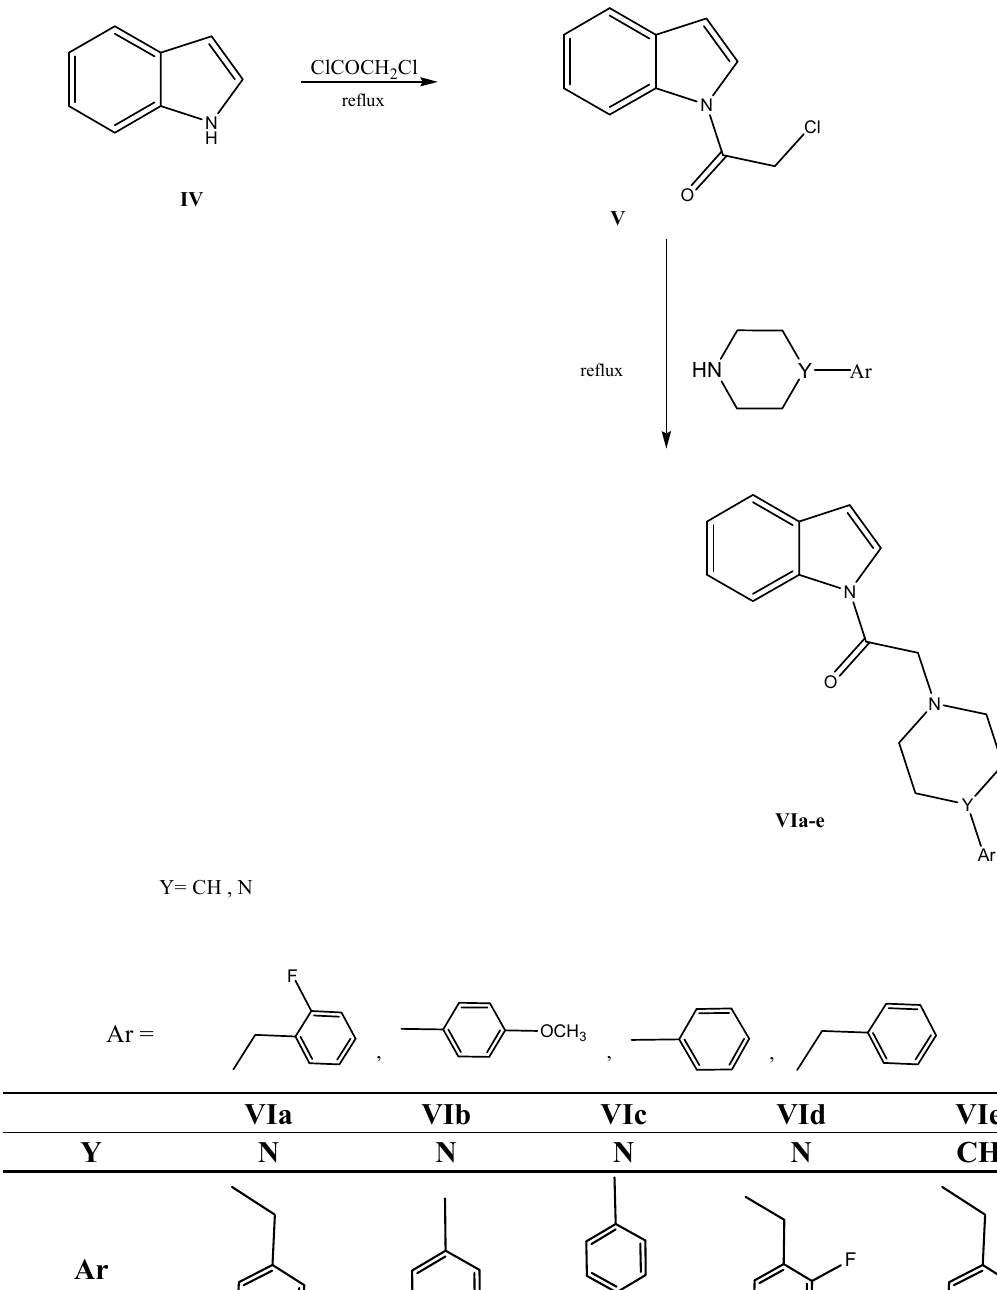
Scheme 2. Synthesis of target compounds VIa – e